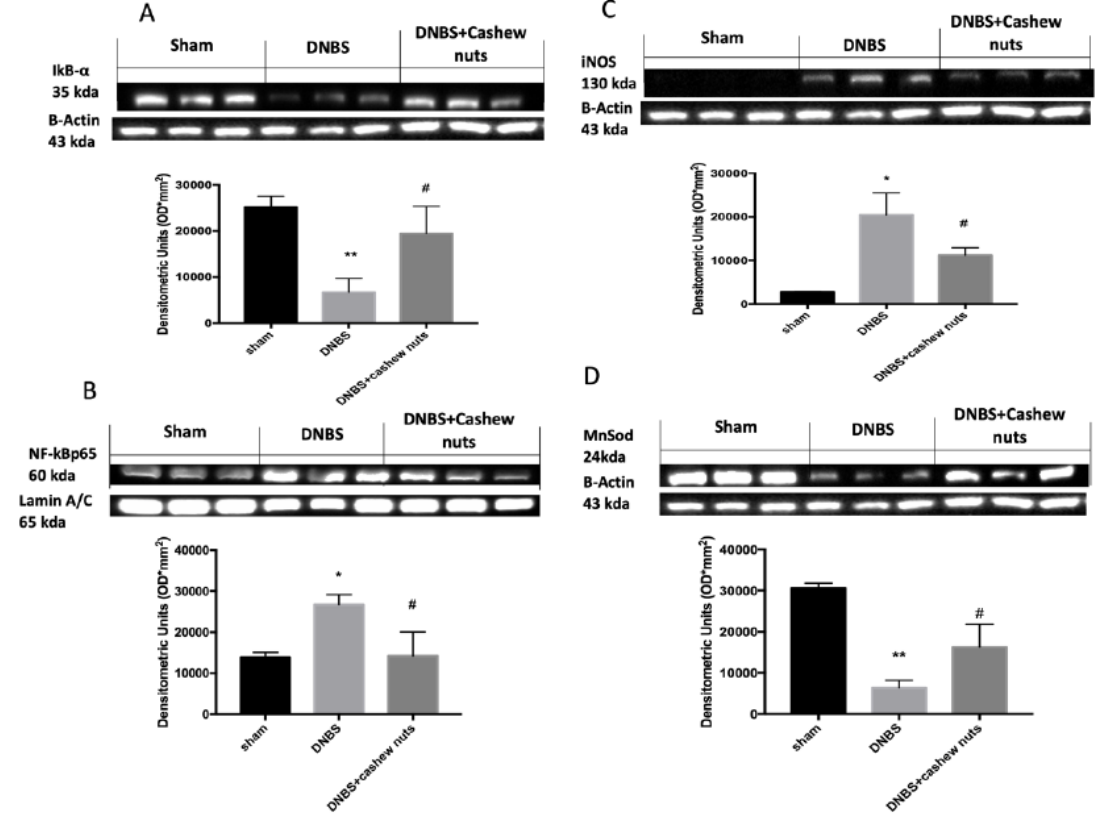
Figure 10. Western blots for NF-kB, IKB- α , iNOS, and MnSOD. Representative Western blots for IKB- α degradation ( A ), NF- κ B translocation ( B ), iNOS ( C ), and MnSOD expression ( D ) were performed. A demonstrative blot of lysates (six animals / group), with a densitometric analysis for all animals is showed. The results in A, B C, D = means ± SEM of six animals in each group. * p < 0.05 vs. sham; ** p < 0.01 vs. sham # p < 0.05 vs.